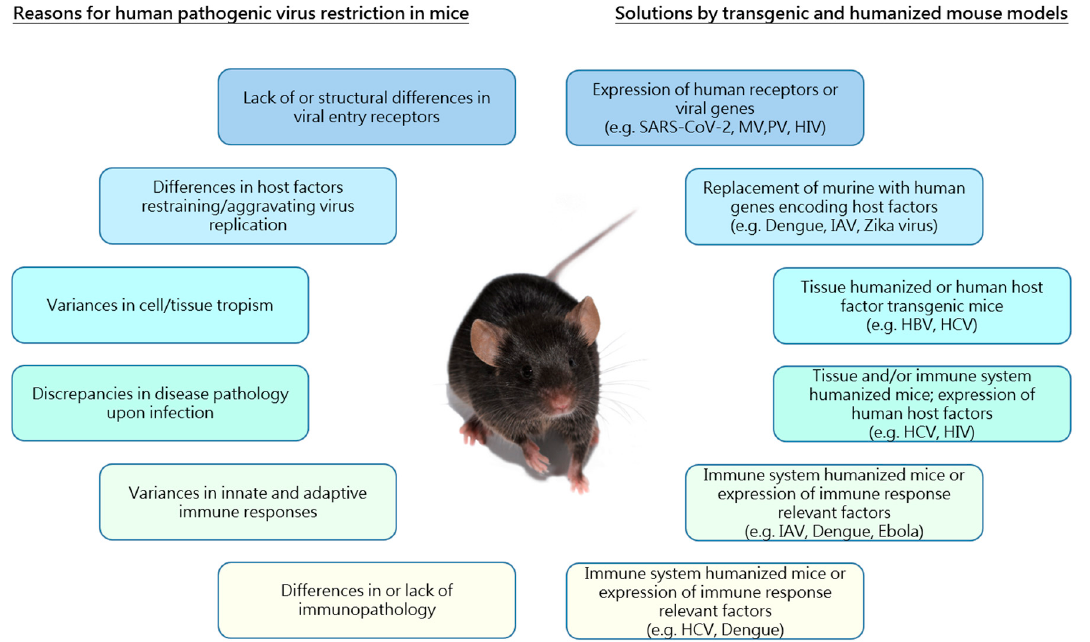
Figure 1. Reasons underlying restricted species specificity of human pathogenic viruses and solutions provided by the use of transgenic and humanized mouse models. Schematic overview of limitations in the use of mouse models for research of human pathogenic viruses (left) and examples of different transgenic/humanized mouse models providing solutions to overcome the respective restrictions (right). Associated boxes (limitations/solutions) are indicated by the use of the same color. MV: Measles virus; PV: Poliovirus; HIV: Human immunodeficiency virus; IAV: Influenza A virus; HBV: Hepatitis B virus; HCV: Hepatitis C virus.